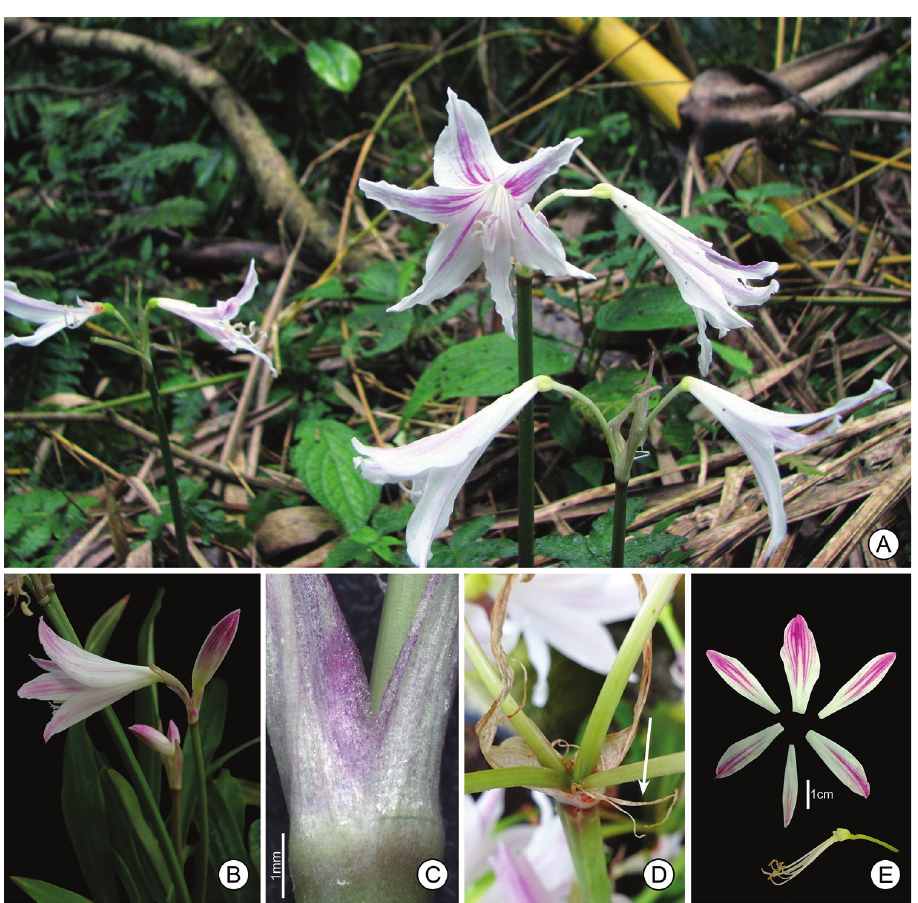
Figure 3. Eithea blumenavia A Flowering plants in habitat B Lateral view of inflorescence C Detail of spathe bracts D Bracteoles (white arrow) E Sepals and petals (adaxial view) separated from stamens and style. B–E of Campos-Rocha 1624 ,